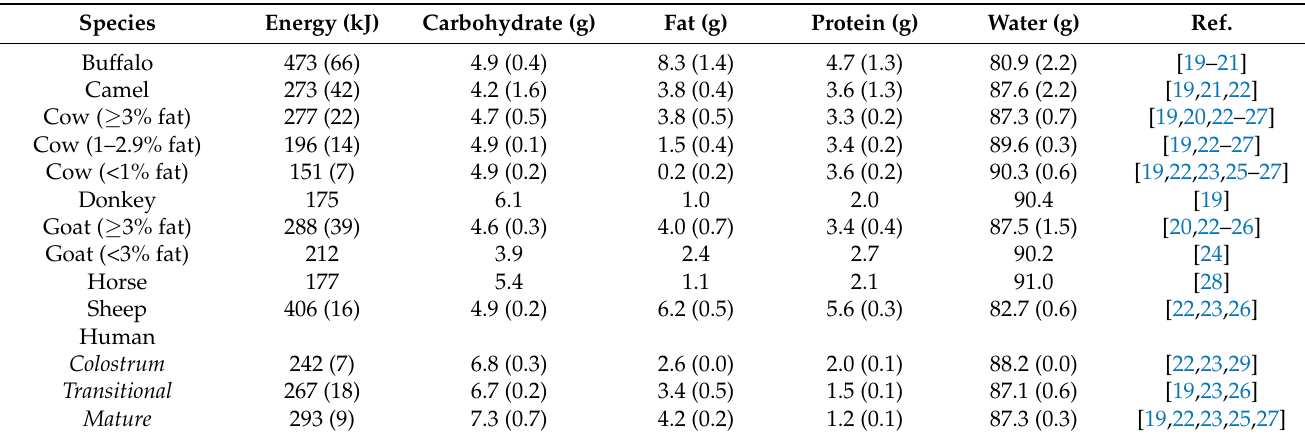
Table 1. Gross composition of milk of different mammals obtained from available food composition databases. Data are presented as an average ( ± standard deviation) per 100